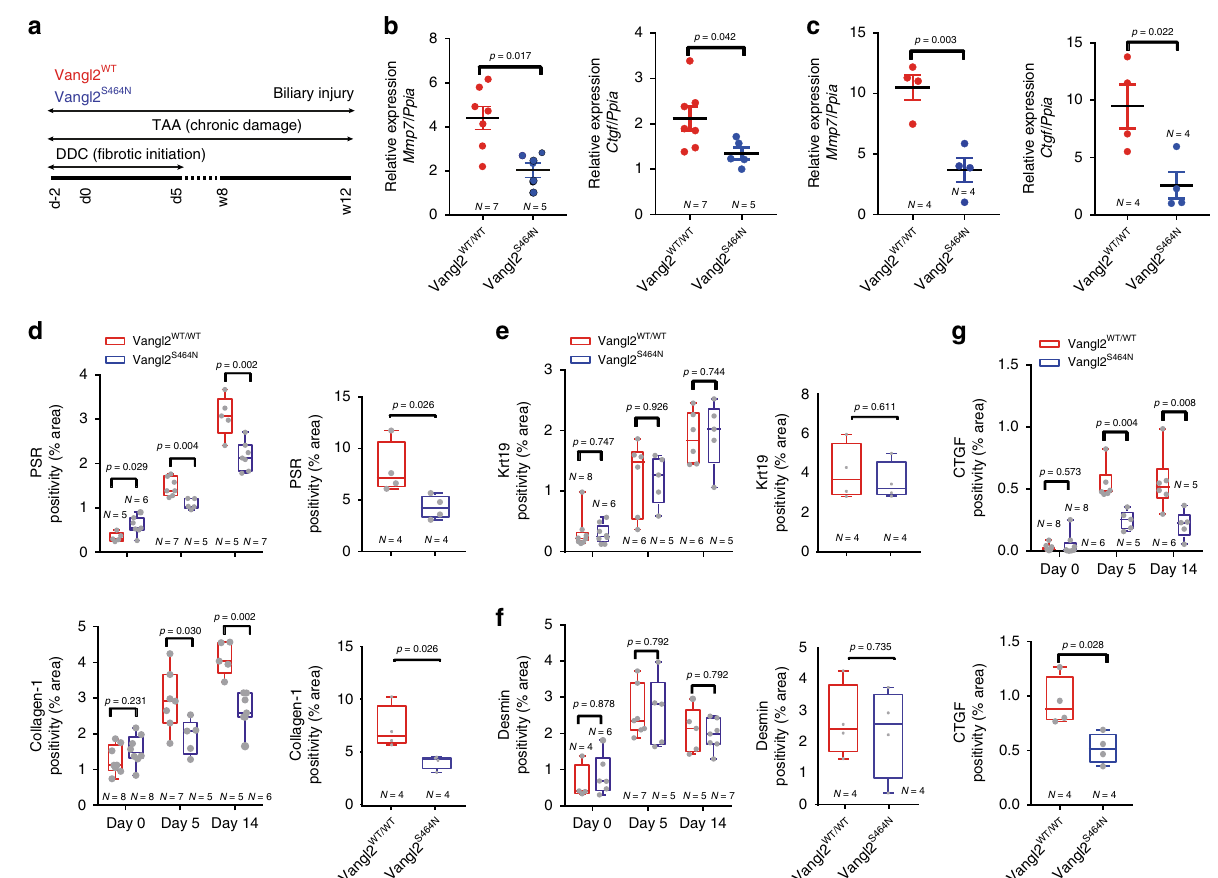
Fig. 5 Inhibition of Wnt-PCP reduces the formation of biliary scars. a Schematic representing the treatment strategy of Vangl2 S464N mutant mice treated with either DDC or TAA to initiate bile duct damage and regeneration. b Relative mRNA expression of Wnt-PCP target genes Ctgf and Mmp7 in DDC and c TAA-induced biliary regeneration normalised to Ppia . d Image quanti fi cation of Picrosirius Red, PSR ( fi brillar collagen) and Collagen-1 in DDC or TAA- induced biliary injury. e Quanti fi cation of the number of BECs (through Keratin-19 immunohistochemistry) following DDC (left panel) or TAA (right panel) in Vangl2 S464N mutant mice compared with controls. f Desmin positivity ( fi broblasts) in mice with DDC or TAA-induced biliary regeneration. g Image analysis and quanti fi cation of CTGF protein levels in mice with DDC (upper panel) or TAA- (bottom panel) induced biliary injury. Source data are provided as a Source Data fi le. In graphs where two groups are included, a Student ’ s t test is used. When comparing multiple groups, a two-way ANOVA with post hoc correction for multiple testing is used. Box – whisker plots represent min – max range of the data. In dot plots, data are presented as mean ± S.E.M. Each data point (N) represents an individual